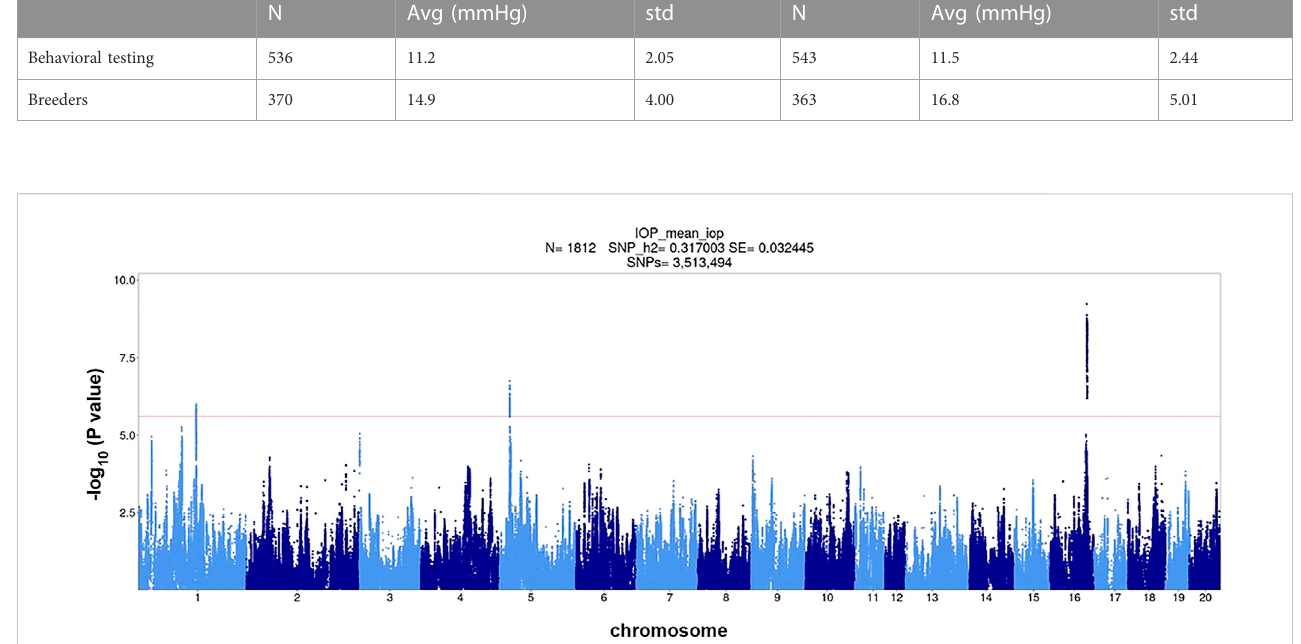
FIGURE 2 Association of ~3.5 million SNPs with IOP measured in 1,812 HS rats. The red horizontal line corresponds to genome-wide signi fi cance level 0.1 ( − log 10 p = 5.67) the dashed red horizontal line corresponds to genome-wide signi fi cance level 0.05 ( − log 10 p = 5.95) as determined by permutation analysis.